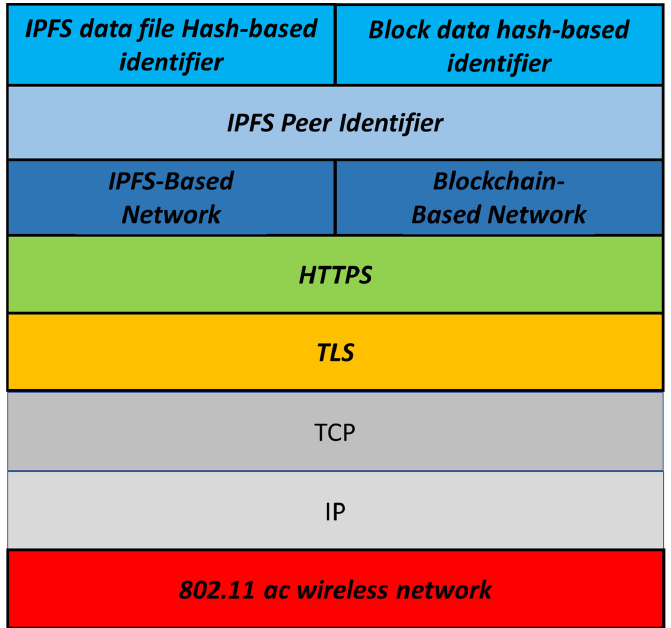
Figure 9. System layers. Security-enhanced ones are highlighted .